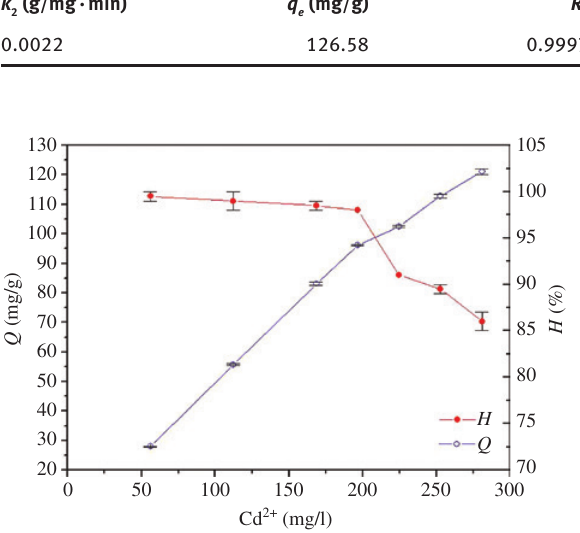
Figure 3: Variation of the Cd 2 + adsorption capacity and efficiency of 0.1 g HAp according to the Cd 2 + initial concentration.